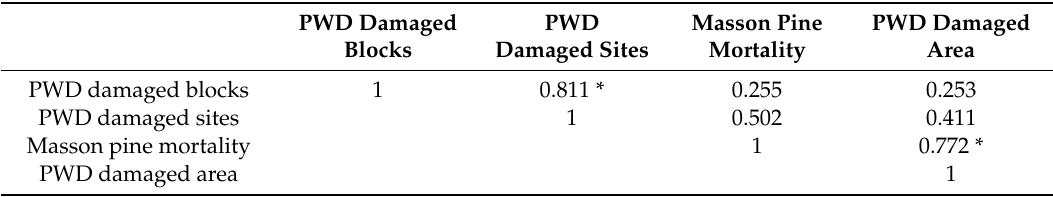
Table 2. The correlation coe ffi cient matrix for the di ff erent pine wilt disease epidemic variables in the study area during 2006 to